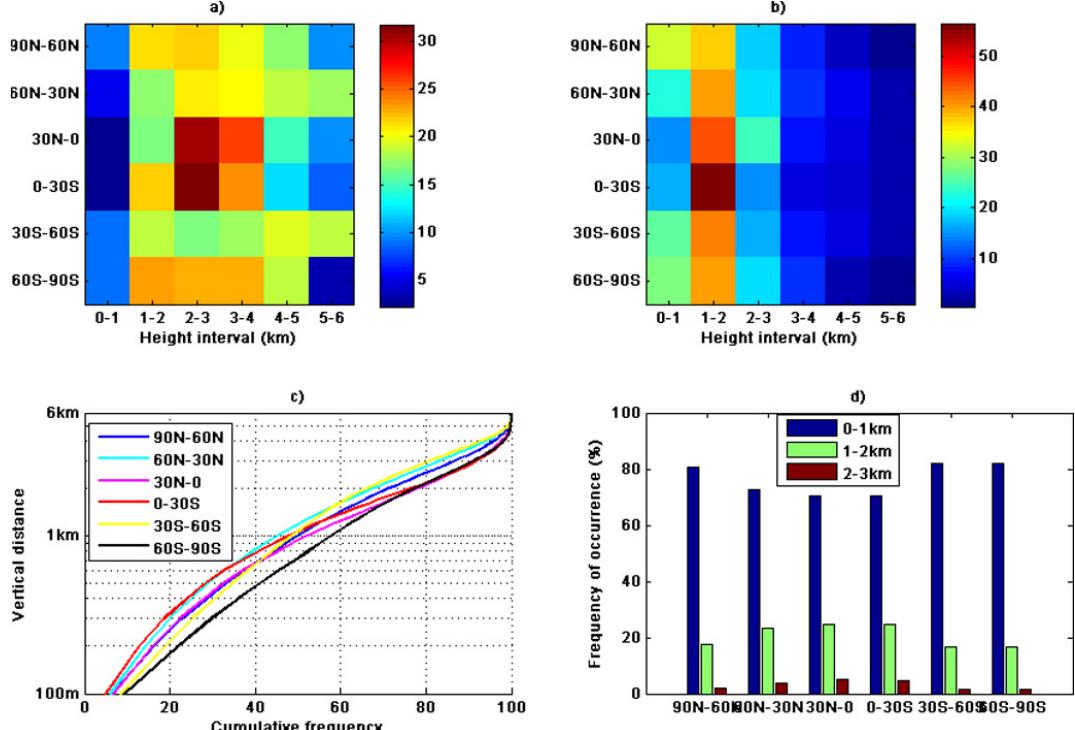
Fig. 9. Annual mean (a) frequency of occurrence of aerosol layer base altitudes; (b) frequency of occurrence of cloud layer top altitudes; (c) cumulative frequency of the vertical distance between aerosol and cloud layers; and (d) frequency of occurrence of aerosol layer geomet- rical thickness in the intervals of 0–1km, 1–2km and 2–3km. Note that all of these statistics are computed only for cases when overlap was